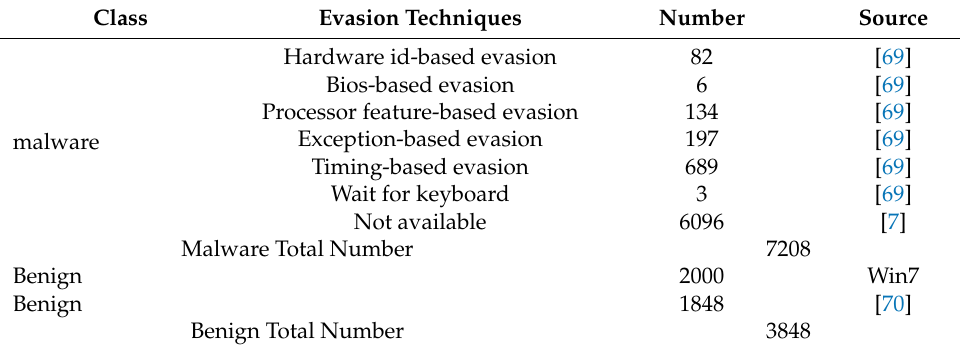
Table 1. Evasive malware types and benign